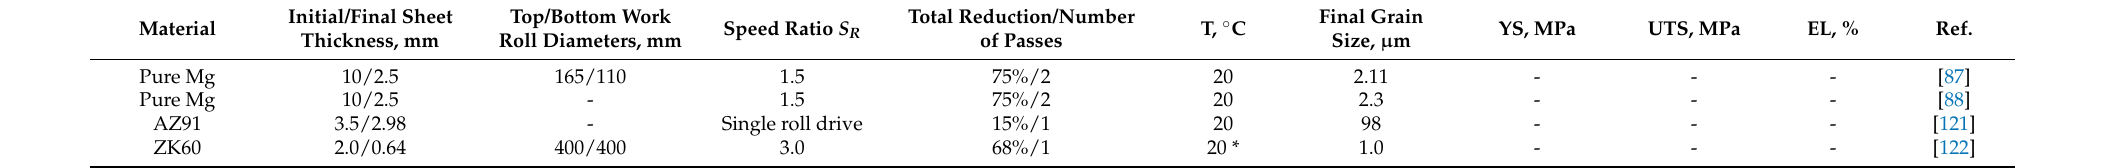
Table 4. Experimental data related to asymmetric cold rolling of Mg